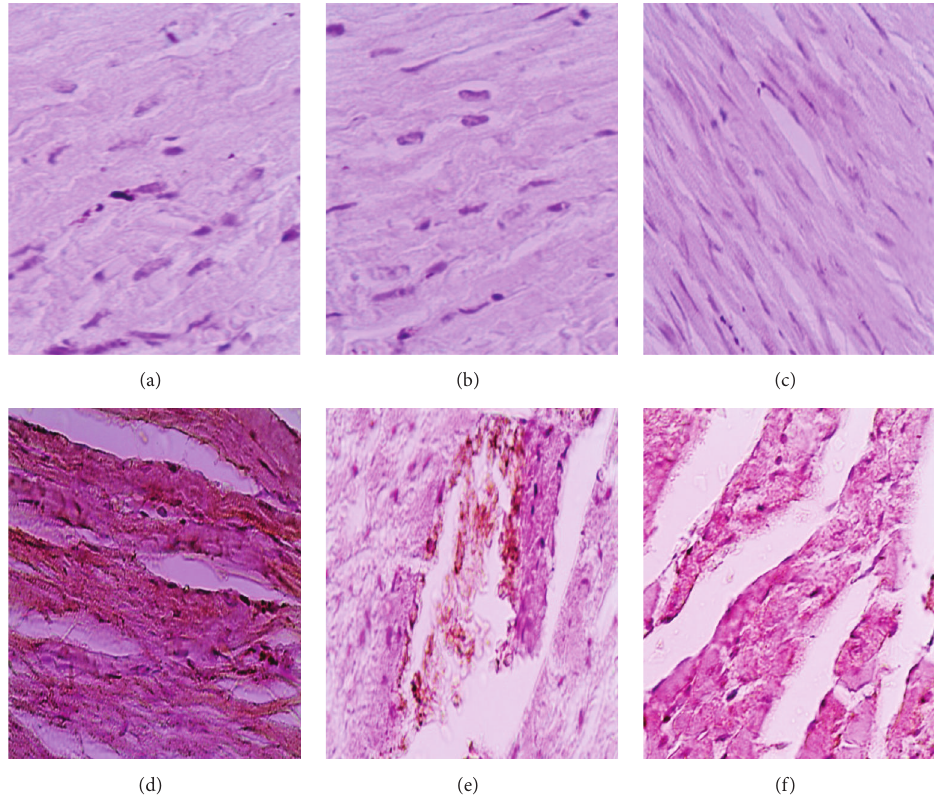
Figure 3: Photomicrography of iNOS immunostaining in the studied different animal groups in the third set. (a), (b), and (c) represent minimal expression sections from the control, metformin, and sitagliptin groups, respectively. (d) represents high iNOS expression found in the DOX group. (e) and (f) represent significantly lower iNOS expression found in the metformin/DOX and sitagliptin/DOX groups, respectively, as compared to (d). DAB was used as a chromogen and haematoxylin as nuclear and counter stain. Magnification used is